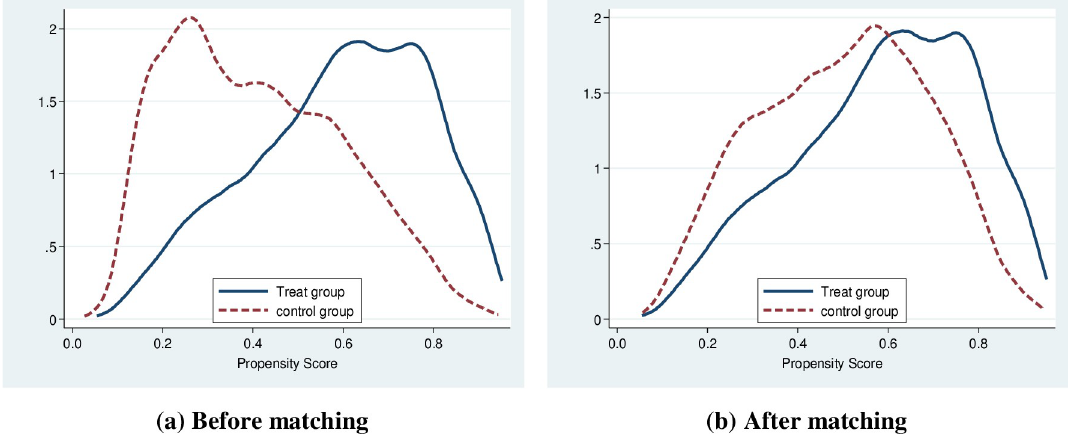
Fig 1. Distribution of propensity scores before and after